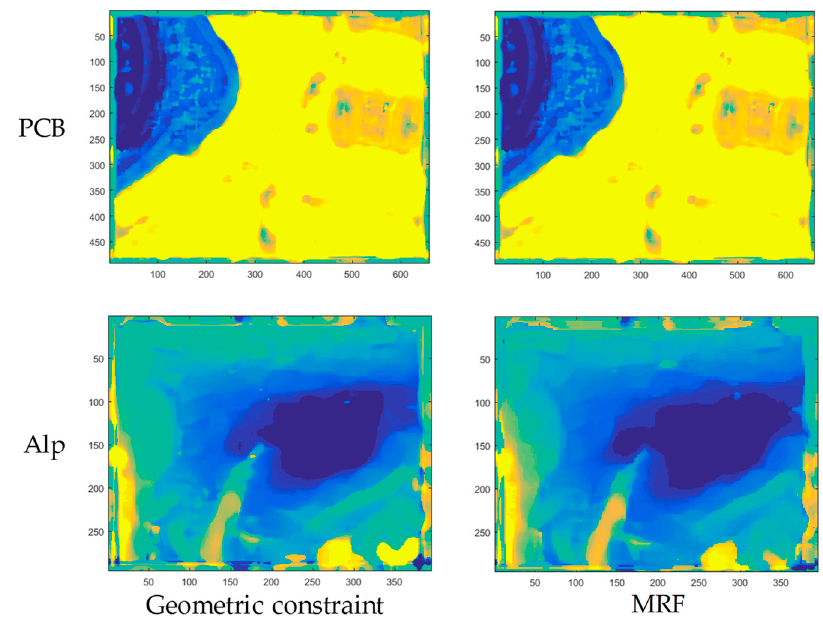
Figure 4. Depth maps obtained by using two depth estimation algorithms: PCB, Alp.